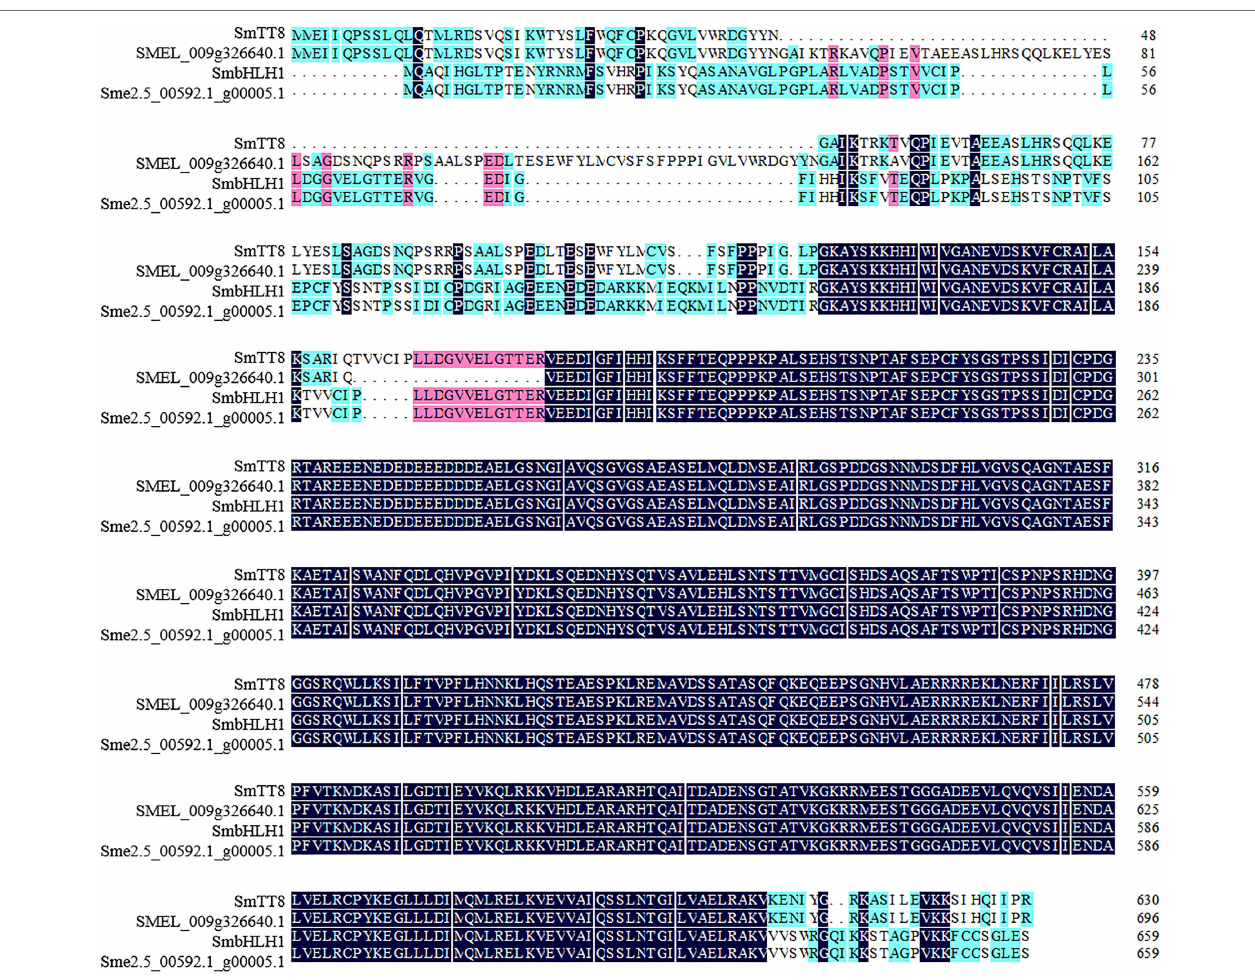
FIGURE 1 | Multiple sequence alignments of the amino acids of SmbHLH1 and SmTT8. SMEL_009g326640.1 and Sme2.5_00592.1_g00005.1 were both annotated as TT8 in the two published eggplant genome